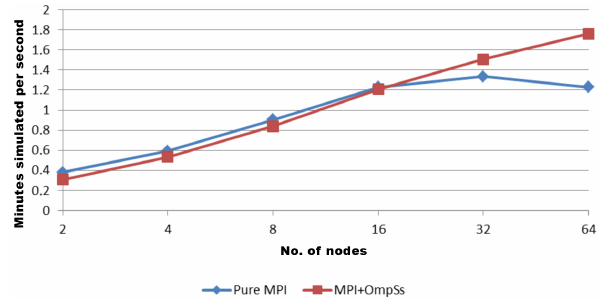
Figure 7. Performance of OmpSs threading in the DEEP